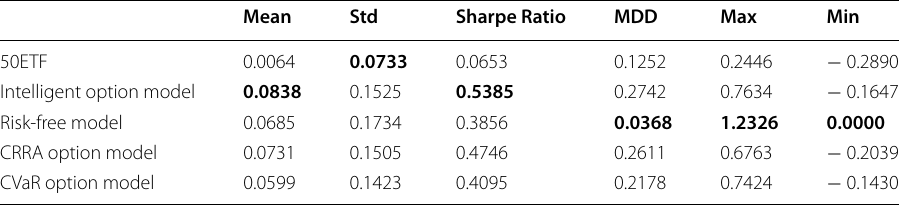
This table displays the out-of-sample performance of 50ETF index and different option strategies with one month adjustment frequency. The performance of different strategies is judged from six dimensions (mean, variance, Sharpe ratio, maximum drawdown, maximum and minimum monthly return), and the bold content indicates the best numerical